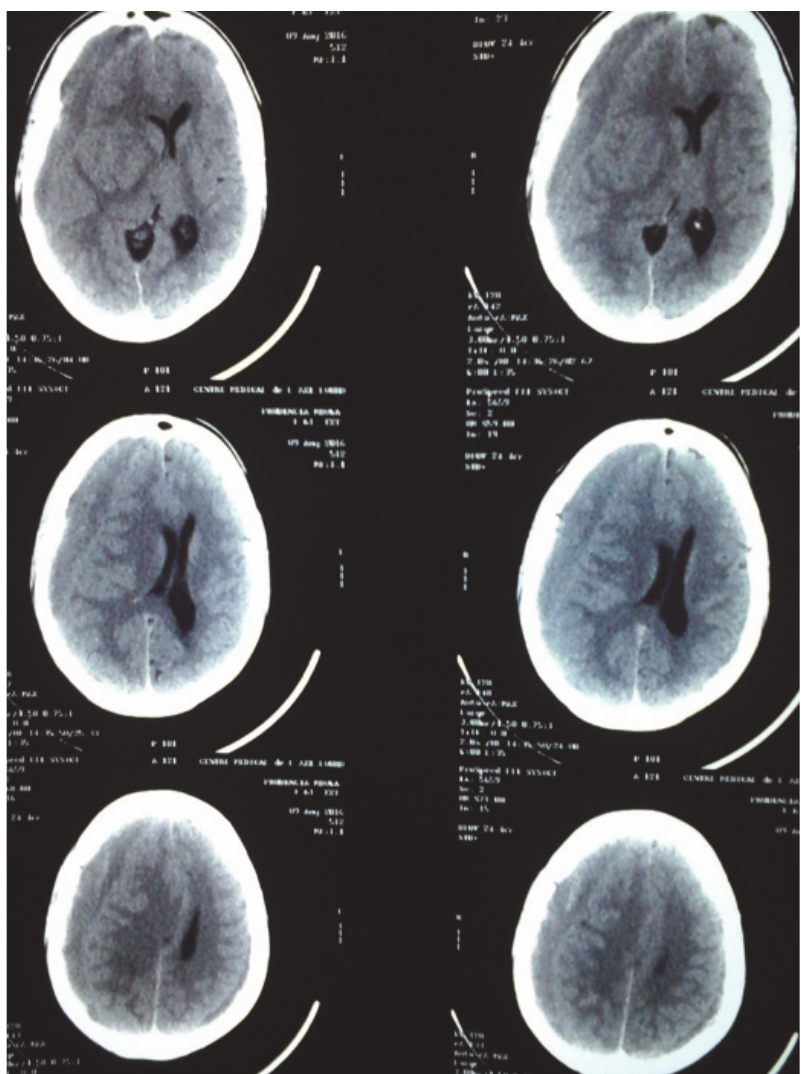
Figure 1: Computed tomography scan of the brain showing a right chronic subdural hematoma with midline